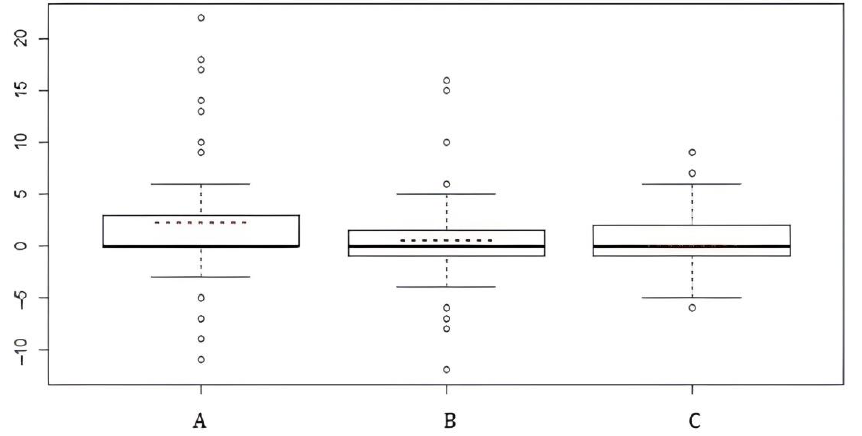
Figure 4. Differences in the total scores, for single monitoring technique, of preoperative VHI and postoperative VHI. A = visual technique; B = intermittent nerve monitoring; C = continuous nerve monitoring. The dashed lines in red represent the mean of these differences, and the lines in bold represent both the median value and the modal value. The position of these three values indicates the concept of symmetry/asymmetry: for the visual monitoring technique (Group A), the difference in scores shows posi- tive asymmetry, which means that the positive scores outweigh the negative, and